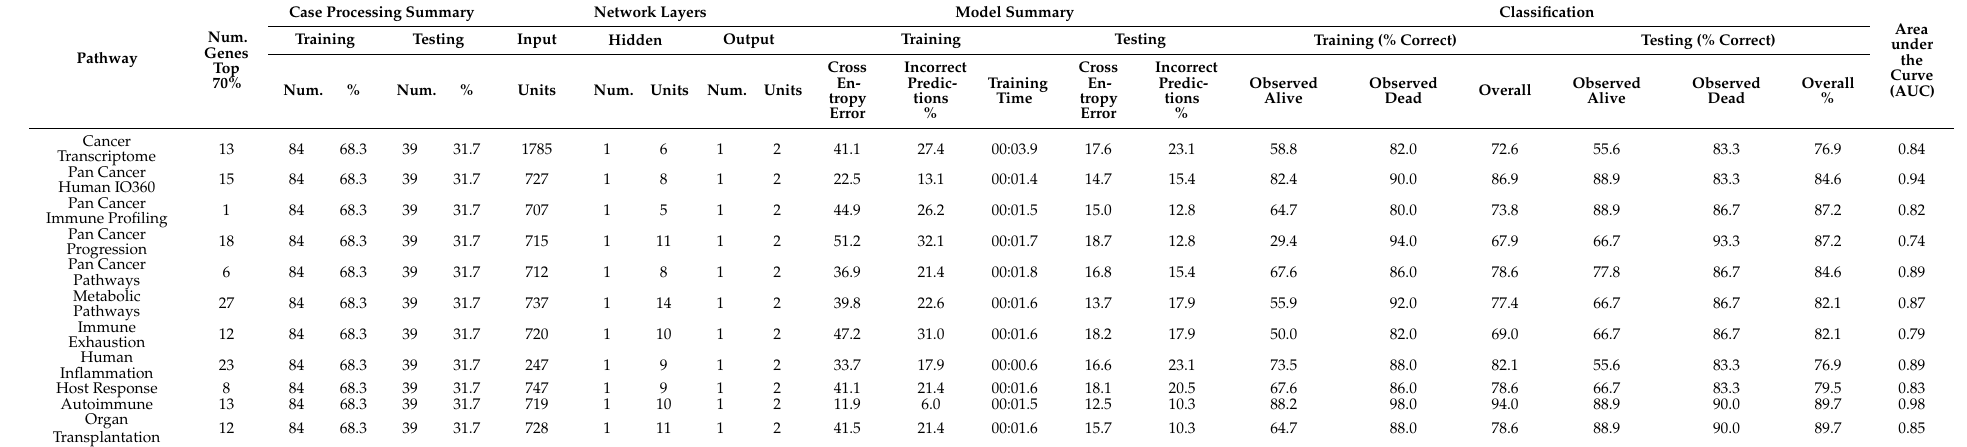
Table A5. Multilayer perceptron analysis of the immuno-oncology pathways (Method